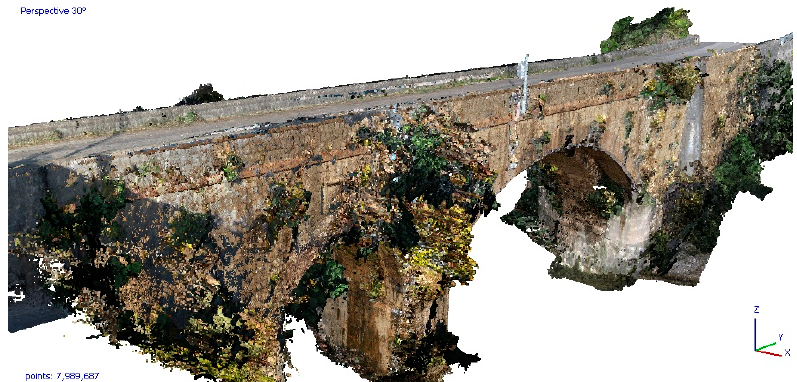
Figure 8. Three-dimensional point cloud of San Cono bridge (visualization in Agisoft Metashape software).